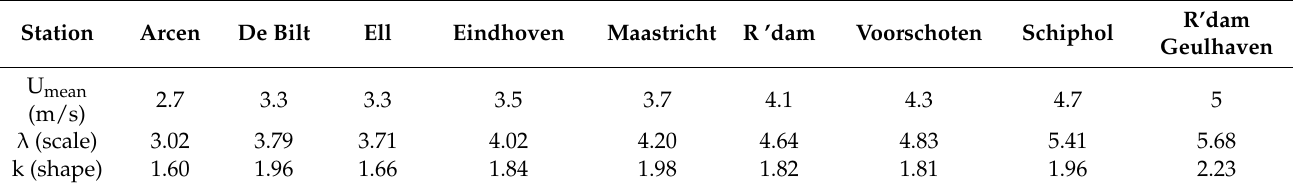
Table 3. Wind Site characteristics including the Weibull lambda and k parameters that describe the wind regime for 9